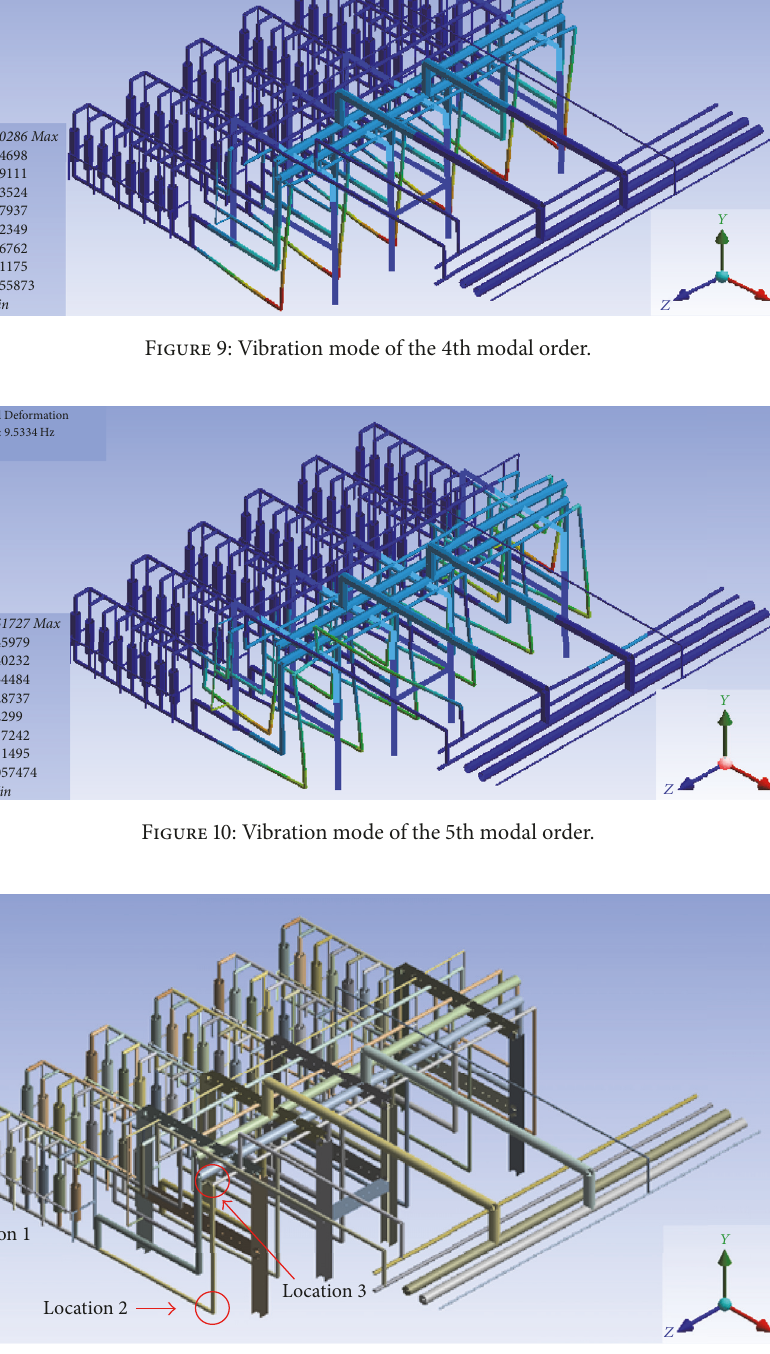
Figure 11: Locations of vibration